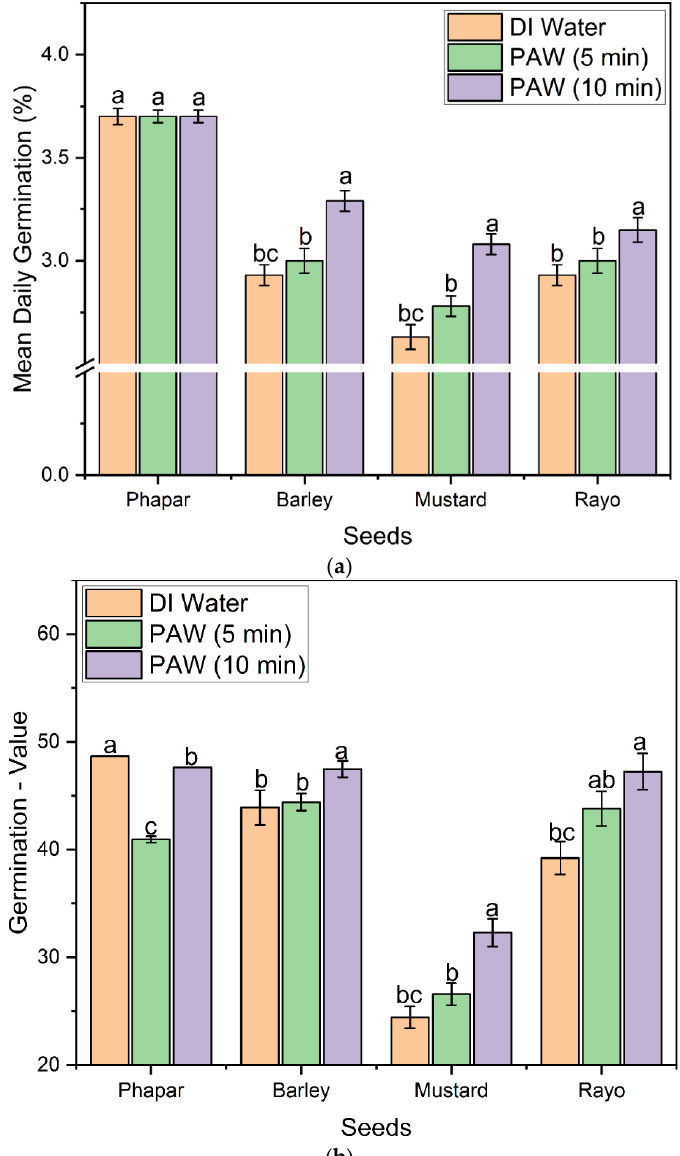
Figure 11. Impact of DI water and PAW on ( a ) mean daily germination (MDG) and ( b ) germination value (G-value) of seeds. Different letters (a – c) indicate significant differences at p < 0.05 level among all treatments as determined by Tukey's multiple comparison test.